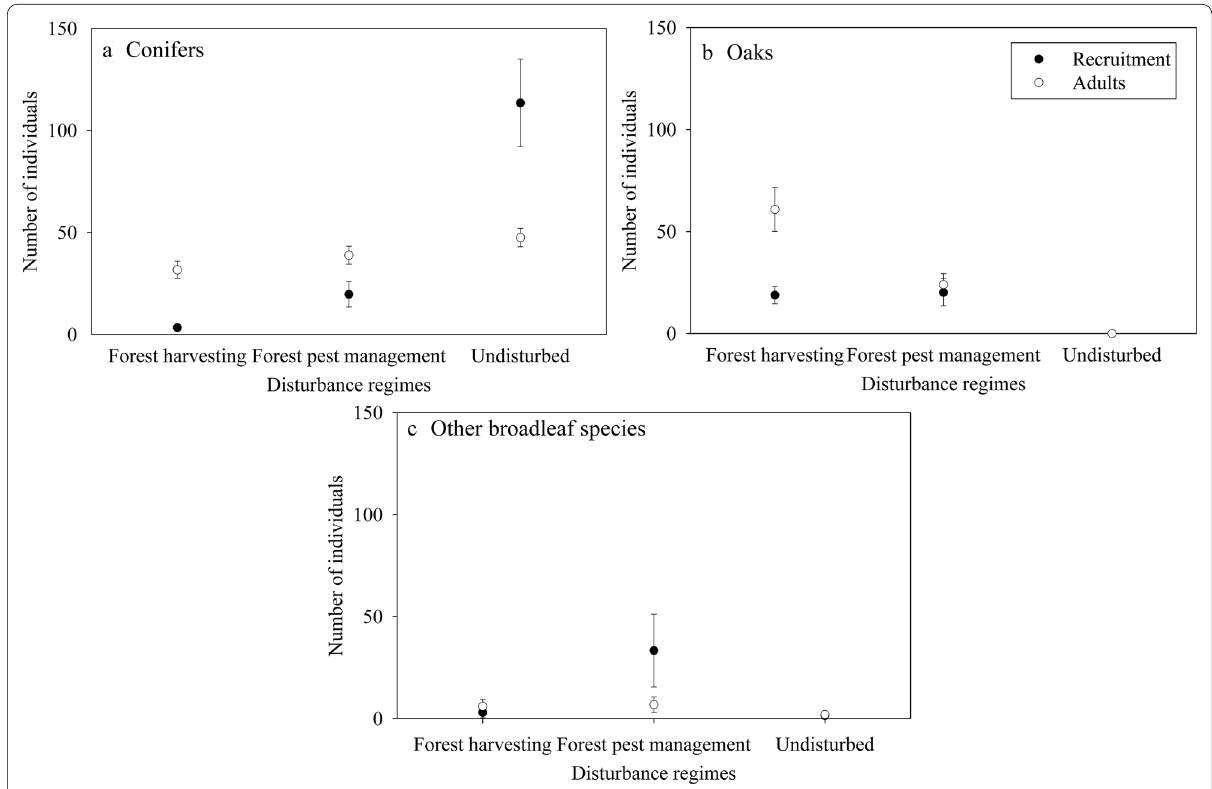
Fig. 3 Averages and standard errors of number of the individual by recruitment (black circles) and adults (white circles) for a conifers, b oaks, and c other broadleaf species according to disturbance regimes (forest harvesting, forest pest management, and undisturbed